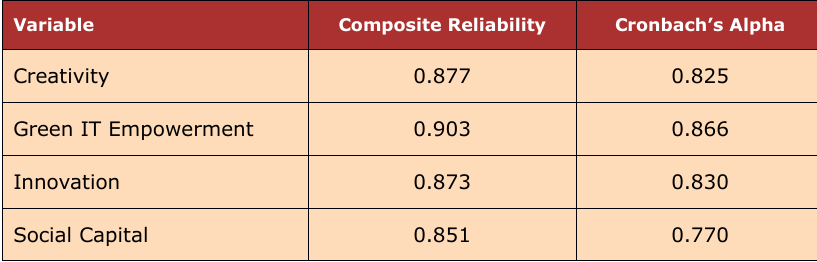
Table 7. Value of Cronbach's Alpha and Composite Reliability